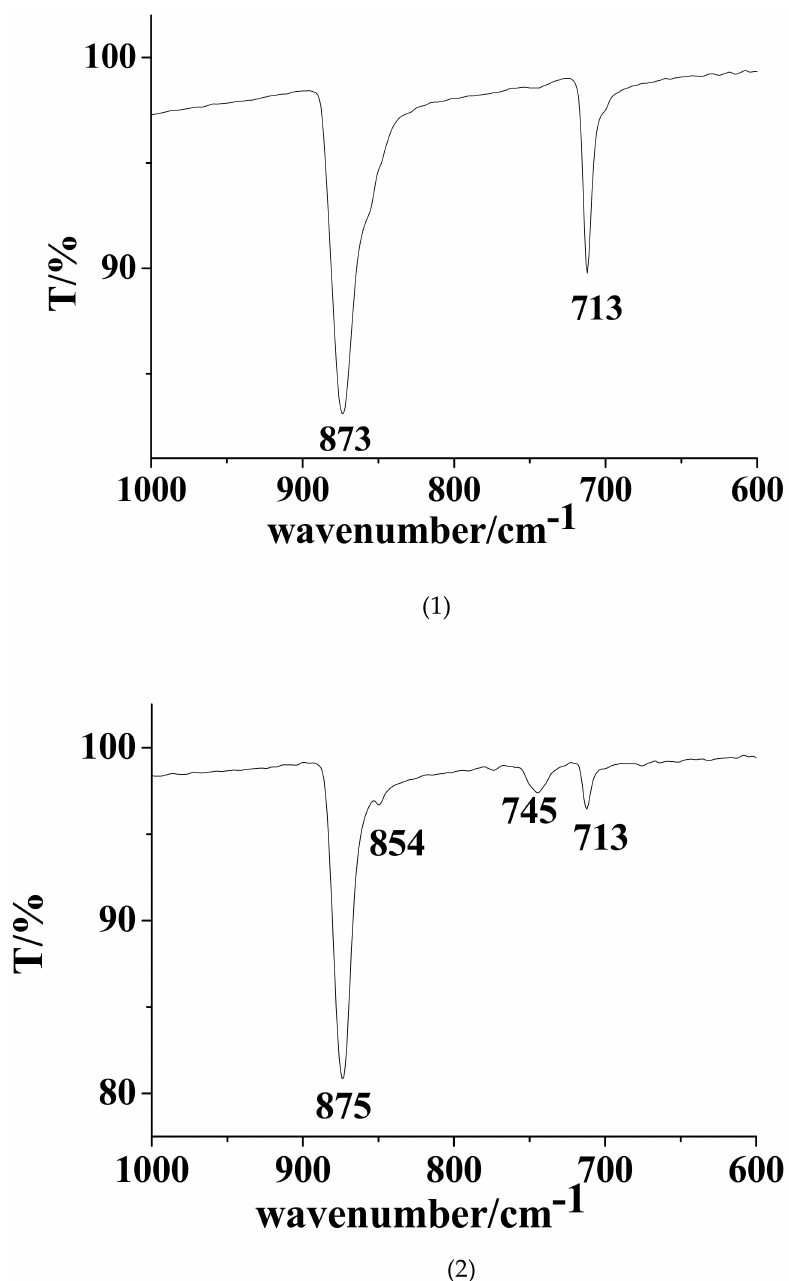
Figure 2. FTIR spectra of CaCO 3 crystals in the scaling solution: ( 1 ) blank; ( 2 ) containing 8 mg / L